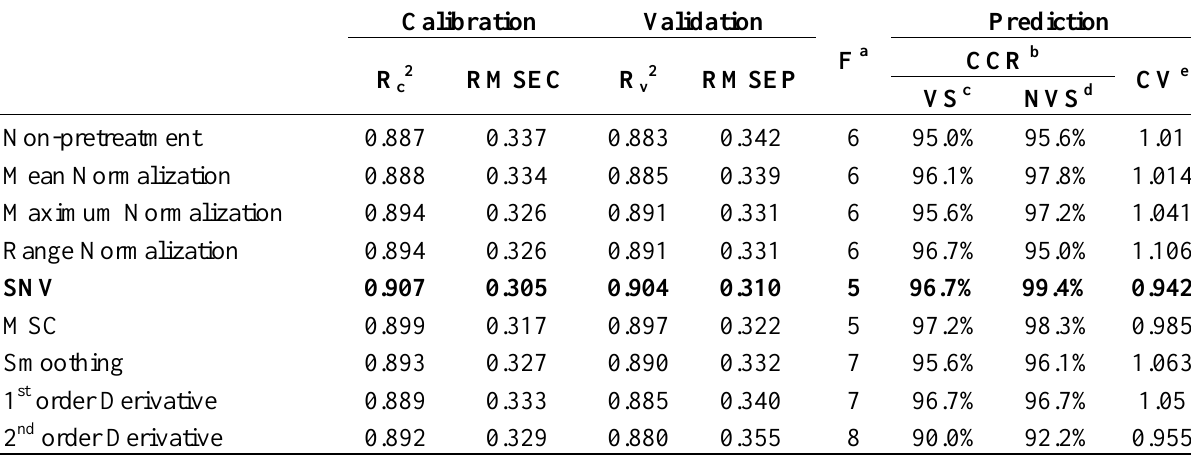
Table 4. Result obtained using the PLS-DA models based on reflectance spectra with RGB LED illumination (400–700 nm).